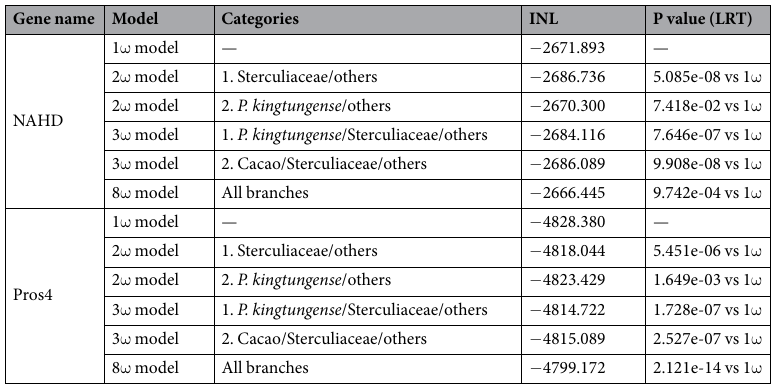
Table 3. Results of Tests of the Differences in dN/dS Ratios between P. kingtungense and